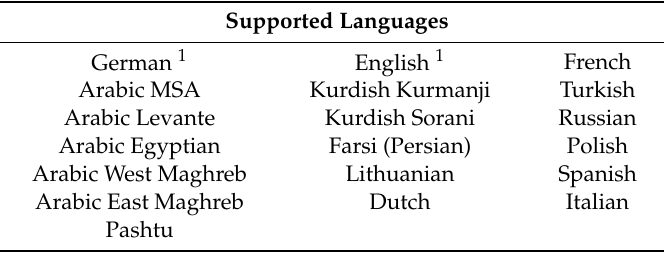
Table 2. Supported